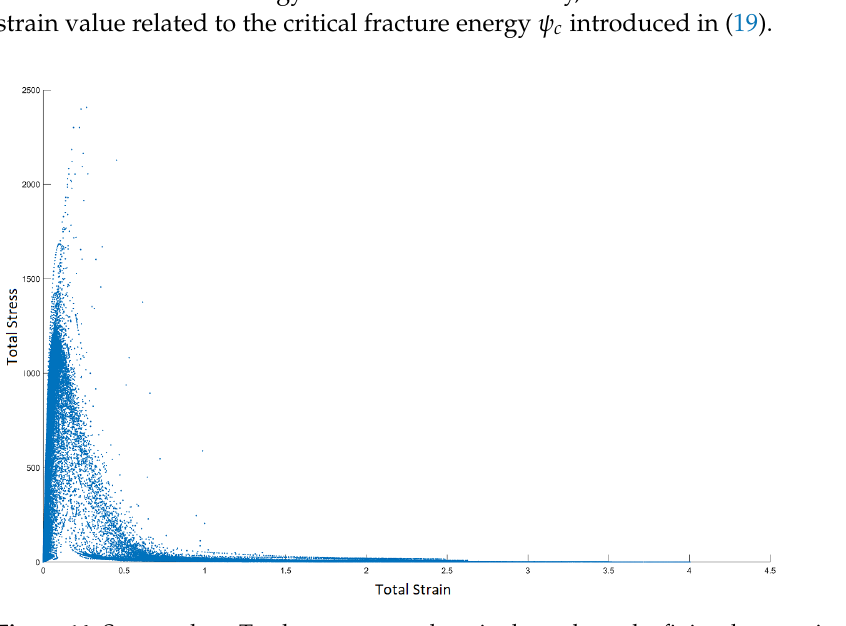
Figure 14. Scatter plots. Total stress vs. total strain throughout the finite element simulation of the phase-field modeling of brittle fracture. The stress unit is [N/mm 2